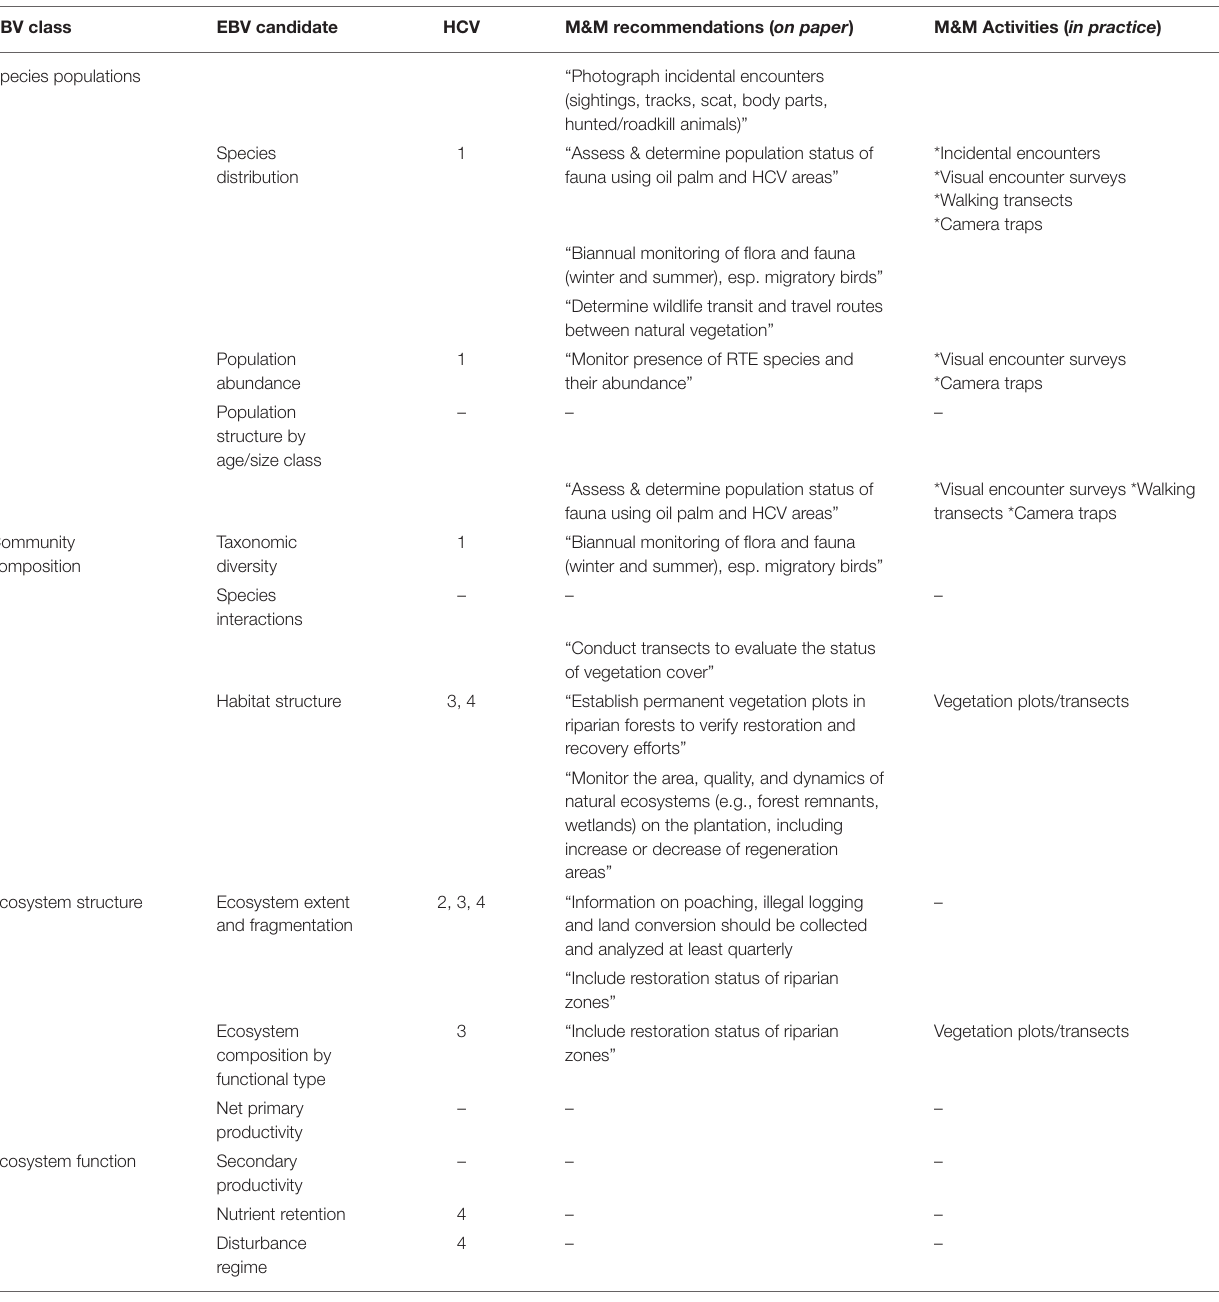
TABLE 1 | Essential biodiversity variable (EBV) classes and candidate variables most relevant to monitoring of HCVs on RSPO-certified plantations, adopted from Pereira et al. (2013) (Note “genetic composition” and “species traits” EBV classes are